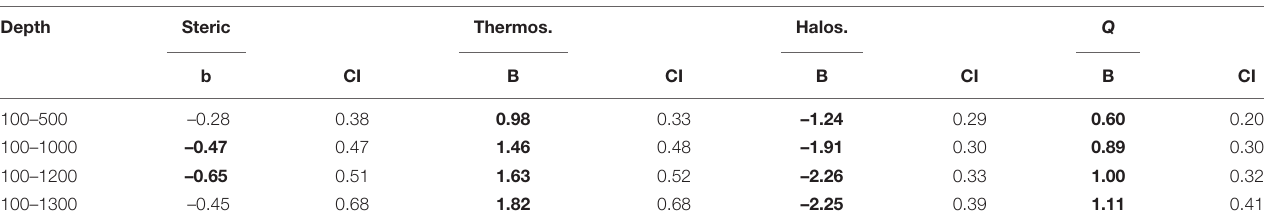
CI represents the confidence intervals for the same time series. The trends for the different components of the steric sea level are estimated for different pressure ranges indicated in the first column. Calculations are repeated including (rows 4–7) and excluding (rows 11–14) the upper 100 dbar. Those values significant at the 95% confidence level are typed in bold, and those significant at the 90% confidence level are typed in gray bold